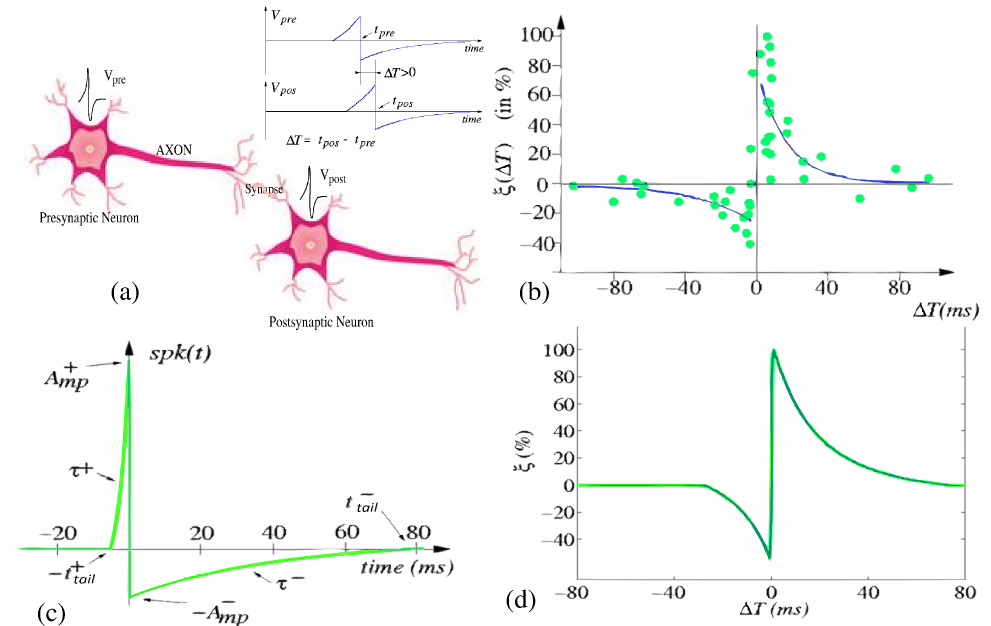
Figure 9. Illustration of STDP learning rule. ( a ) Pre-synaptic neuron generating a spike V pre at time t pre that arrives to a post-synaptic neuron that generates a spike V post at time t post , being ∆ T = t post − t pre , and ( b ) illustrates the variation of the synaptic efficacy ξ ( ∆ T ) Vs ∆ T , STDP learning rule, as the observed by Bi and Poo in biological synapses. ( c ) Illustrates the spike shape that applied to the memristive devices describes in Section 4 reproduces the STDP learning rule shown in ( d